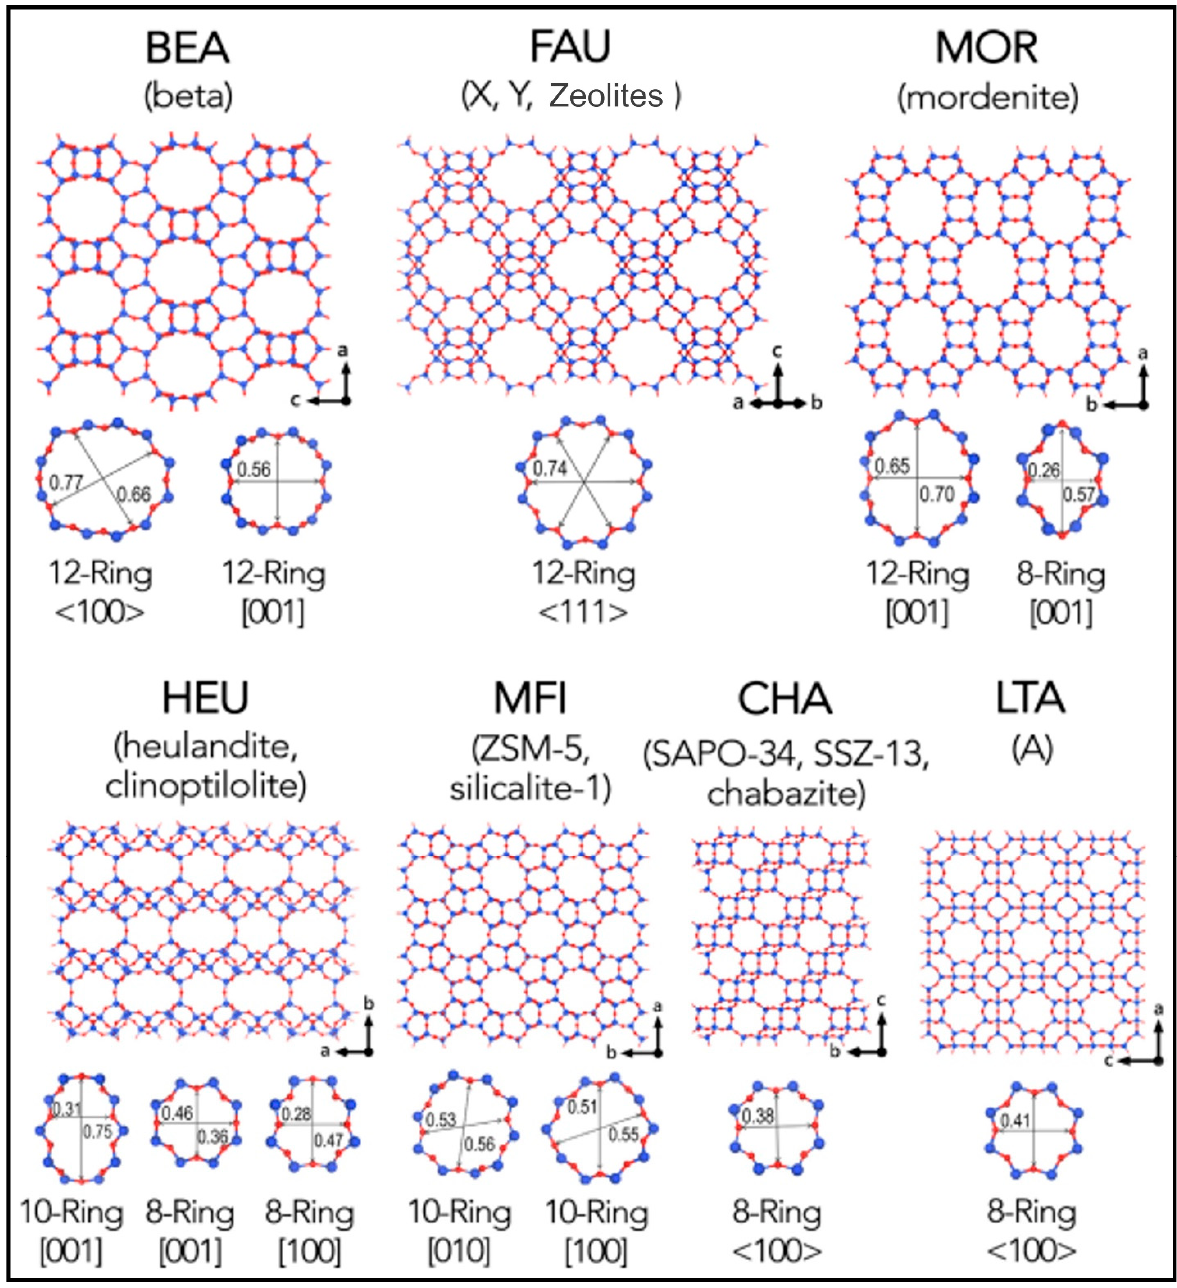
Figure 3. Shows the selected zeolite structures framework assigned with a three-letter code by the International Zeolite Association. Zeolites are classified based on their widest pore windows: small-pore ( ≤ 8-ring), medium-pore (10-ring), large-pore (12-ring), and extra-large-pore zeolites (>12-ring) [66].